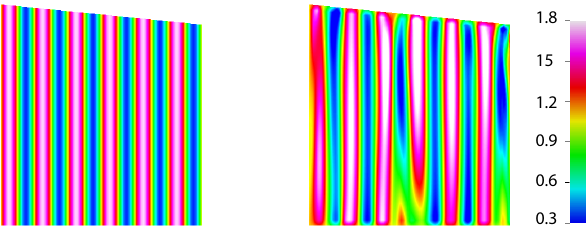
Fig. 7. Comparison of the obtained inverted enhancement factor field for the Control method assuming only changes in a horizontal plane ( E η ( x,y ) , left) or changes in all 3 directions ( E η ( x,y,z ) , right). The inverted field E η ( x,y ) in the left is virtually identical to the one prescribed to obtain the observed velocities (Eq. (66)).